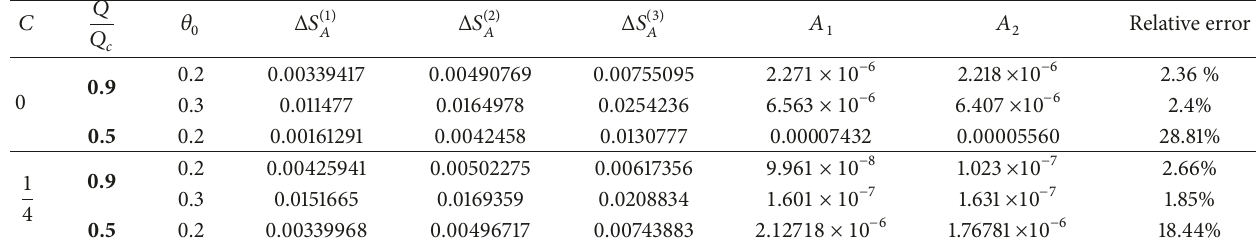
Figure4:Plotofisochargesonthe (𝑇, Δ𝑆 𝐴 ) -plan,fordifferentvaluesof 𝜃 0 ,𝐶 .Forallpanels:thevaluesofthechargeare 𝑄 = .9𝑄 𝑐 (red), 𝑄 = 𝑄 𝑐 (dashed black), and 𝑄 = 2𝑄 𝑐 (green). The coexistence phase isotherm 𝑇 ⋆ (dashed magenta line) is obtained from the free energy (Figure 2) and the critical temperature (dashed orange line). For all curves, we also show the data points which are used to create the interpolation. Table 3: Comparison of 𝐴 1 and 𝐴 2 for the EMPYM-AdS black hole using entanglement